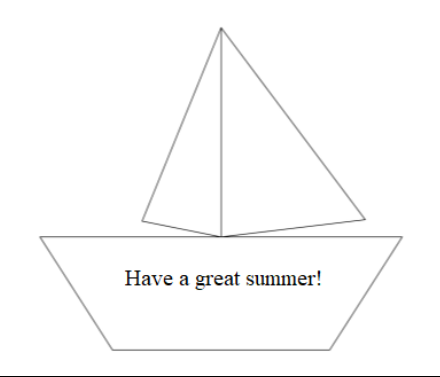
Figure 1. An Example Digital Postcard Created by Using Linear